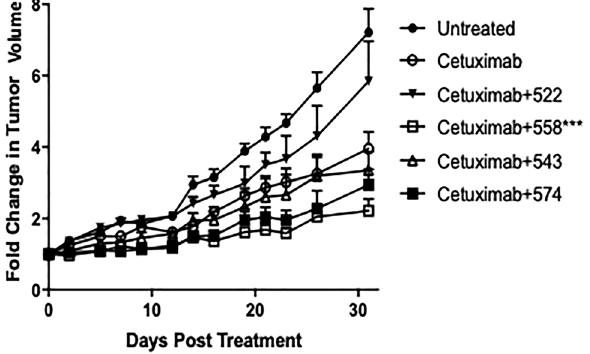
Figure 4. Efficacy study in Balb/c nude mice bearing A549 subcutaneous tumors. Cetuximab + 558 showed significantly improved tumor growth inhibition over Cetuximab alone (P < 0.001 for Cetuximab + 558 v/s Cetuximab alone, two-way ANOVA with multiple comparisons). Statistical significance is based on comparisons from the last day of the study.